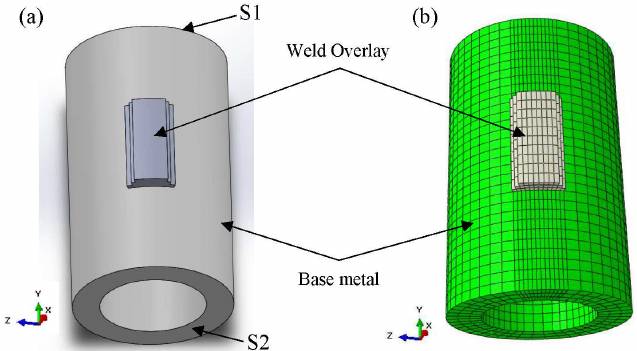
Figure 4. Weld overlay model in the work: ( a ) three-dimensional stereogram and ( b ) finite element mesh model.